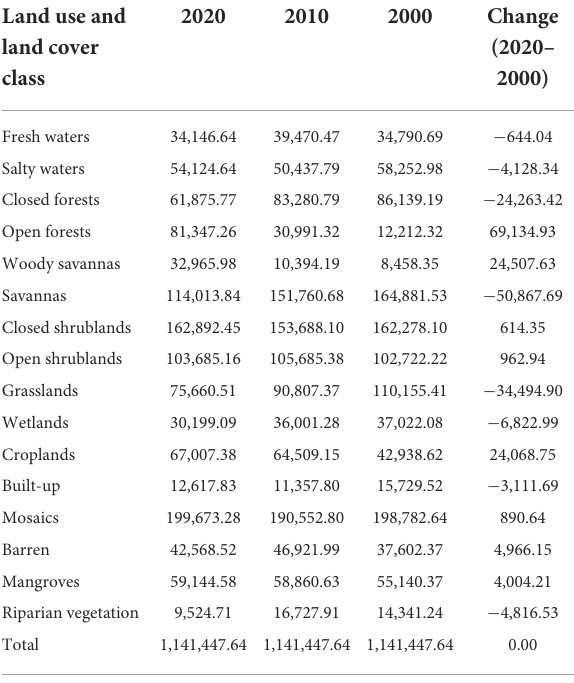
TABLE 3 Quantitative estimates of changes in major land use and land cover of The Gambia between 2000 and 2020. Land use